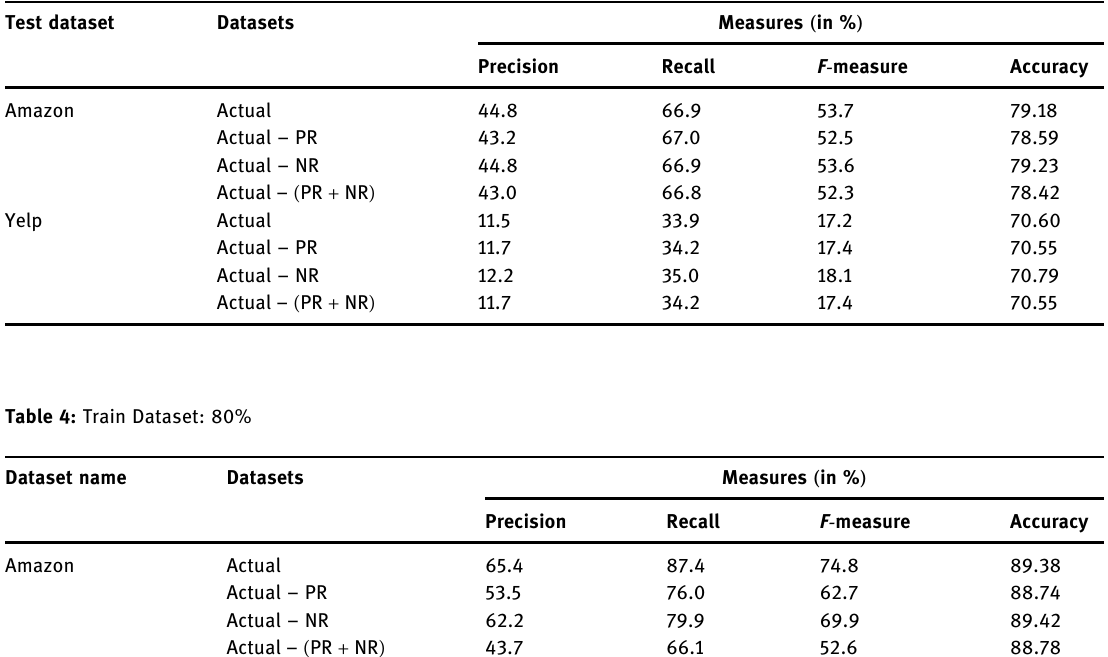
Table 3: Test dataset: 20% Test dataset